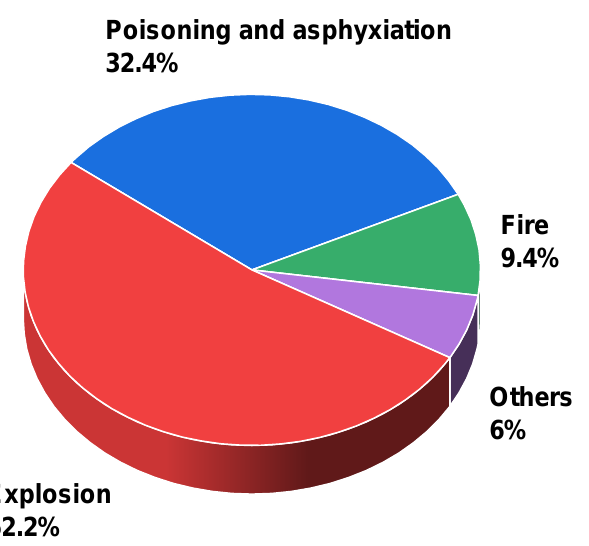
Figure 4. Percentage of different accident types.